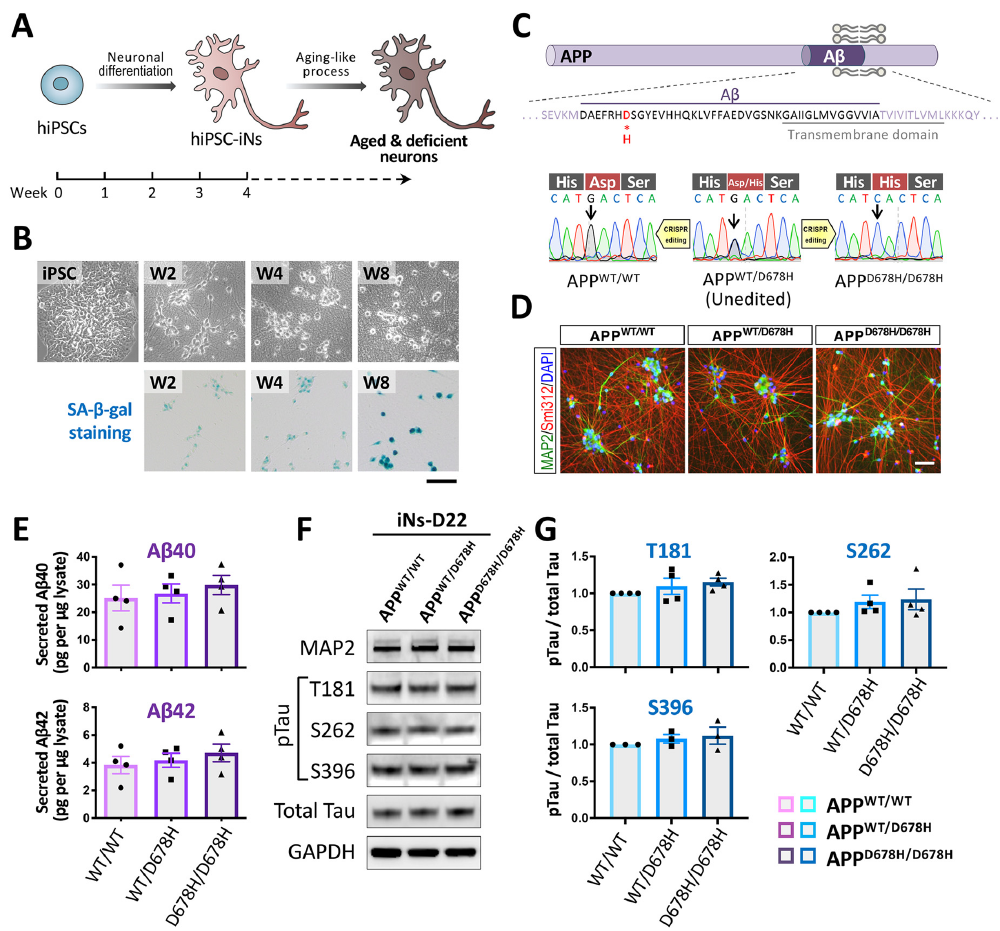
Figure 2. The early mature hiPSC-iNs derived from an AD patient show no significant changes in neuronal morphology and AD pathological characteristics. ( A ) The hiPSCs are induced to differentiate into neuronal cells by the Ngn2 overexpression method. Senescence-like features can be elicited by various strategies in mature hiPSC-iNs. ( B ) SA- β -gal activity is increased in the hiPSC-iNs after a prolonged culture of 8 weeks. Scale bar, 50 μ m. ( C ) The diagram presents human APP protein and the D678H (the 678th amino acid using the APP770 numbering) mutation within the A β region of AD-iPSC (upper panel). Direct sequencing of the APP exon 16 PCR products derived from the patient revealed a GAC-to-CAC nucleotide substitution in the A β region of the patient's APP gene. The CRISPR-edited isogenic hiPSC clones were confirmed by Sanger sequencing (lower panel). ( D ) Representative images of isogenic iPSC-derived glutamatergic neurons immunolabeled for the dendritic and axonal markers, MAP2 and Smi312, respectively, at day 22. Scale bar, 50 μ m. ( E ) The amount of A β 40 and A β 42 secreted from the isogenic iPSC-derived neurons (n = 4). ( F ) Western blot analysis was used to monitor the expression of phosphorylated tau at T181, S262, S396, and total tau in the isogenic iPSC-derived neurons. GAPDH (glyceraldehyde-3-phosphate dehydrogenase) was used to confirm similar protein loadings across the samples. ( G ) Quantitative results of ( F ). The intensity of the pTau signals was normalized against total Tau.